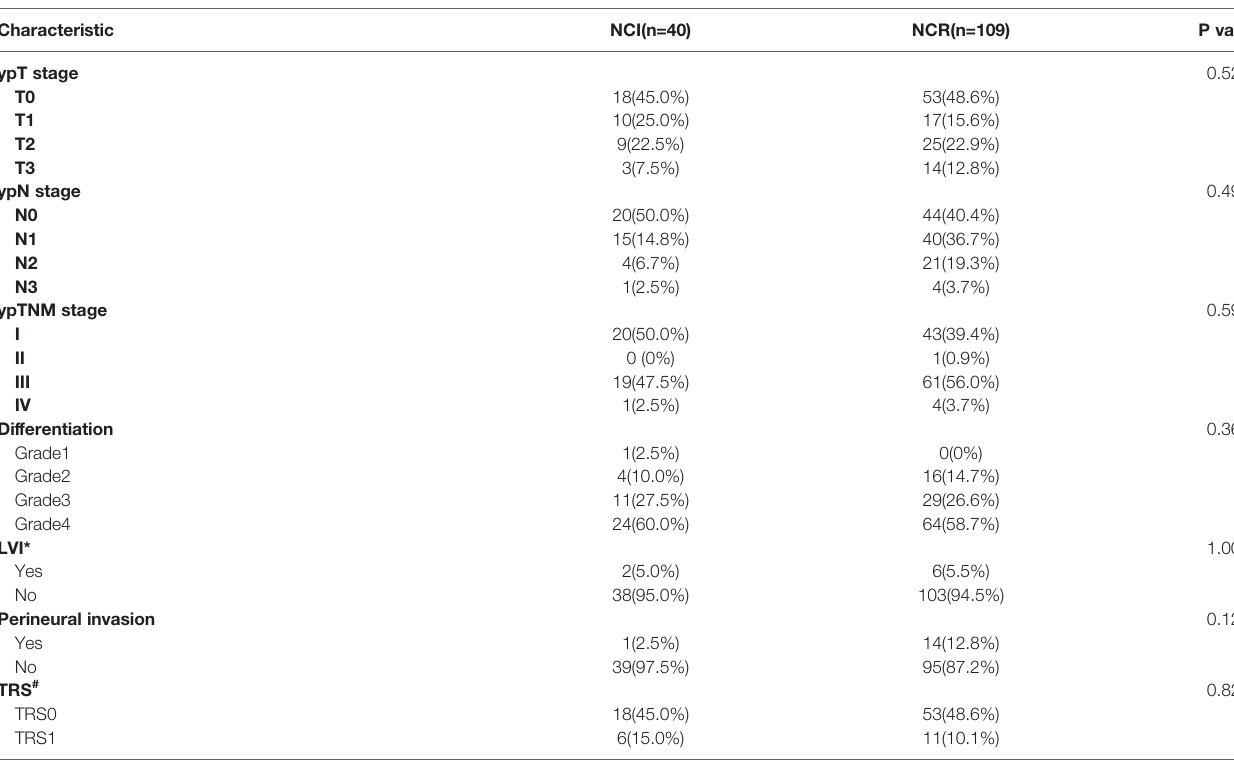
TABLE 4 | The outcomes of